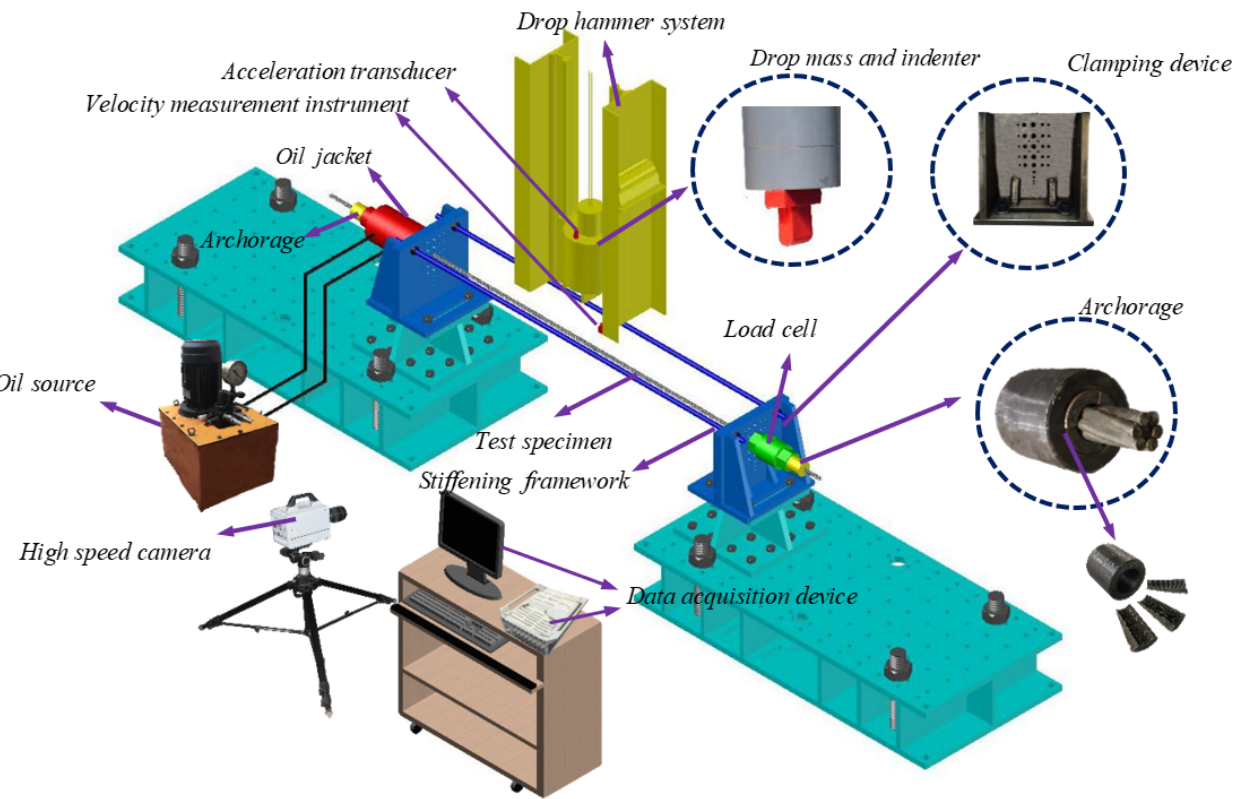
Figure 5. Schematic arrangement for the impact tests on pre − tensioned strand.